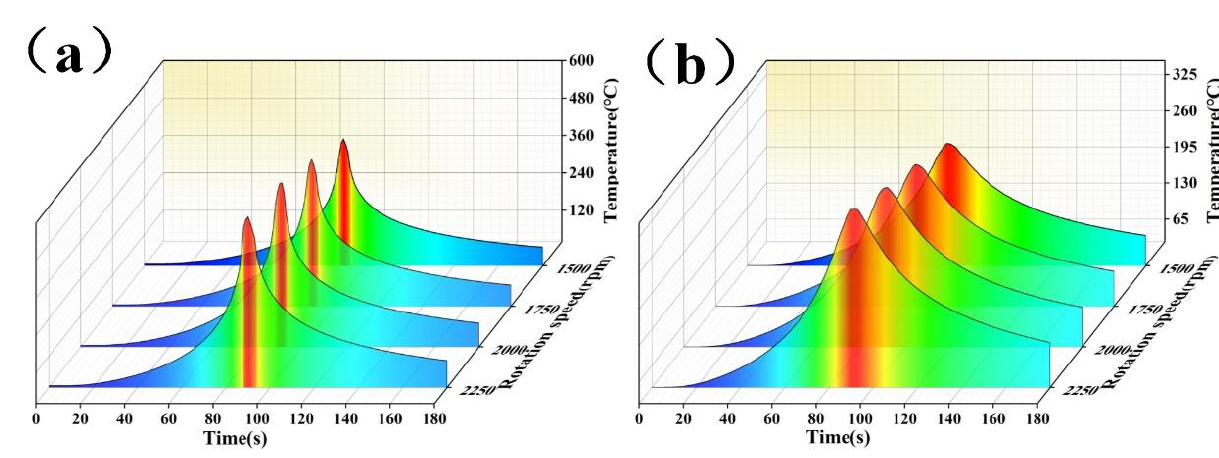
Figure 12. Temperature variation in various regions of welded T-joints at different rotation speeds: ( a ) WNZ, ( b ) TMAZ.